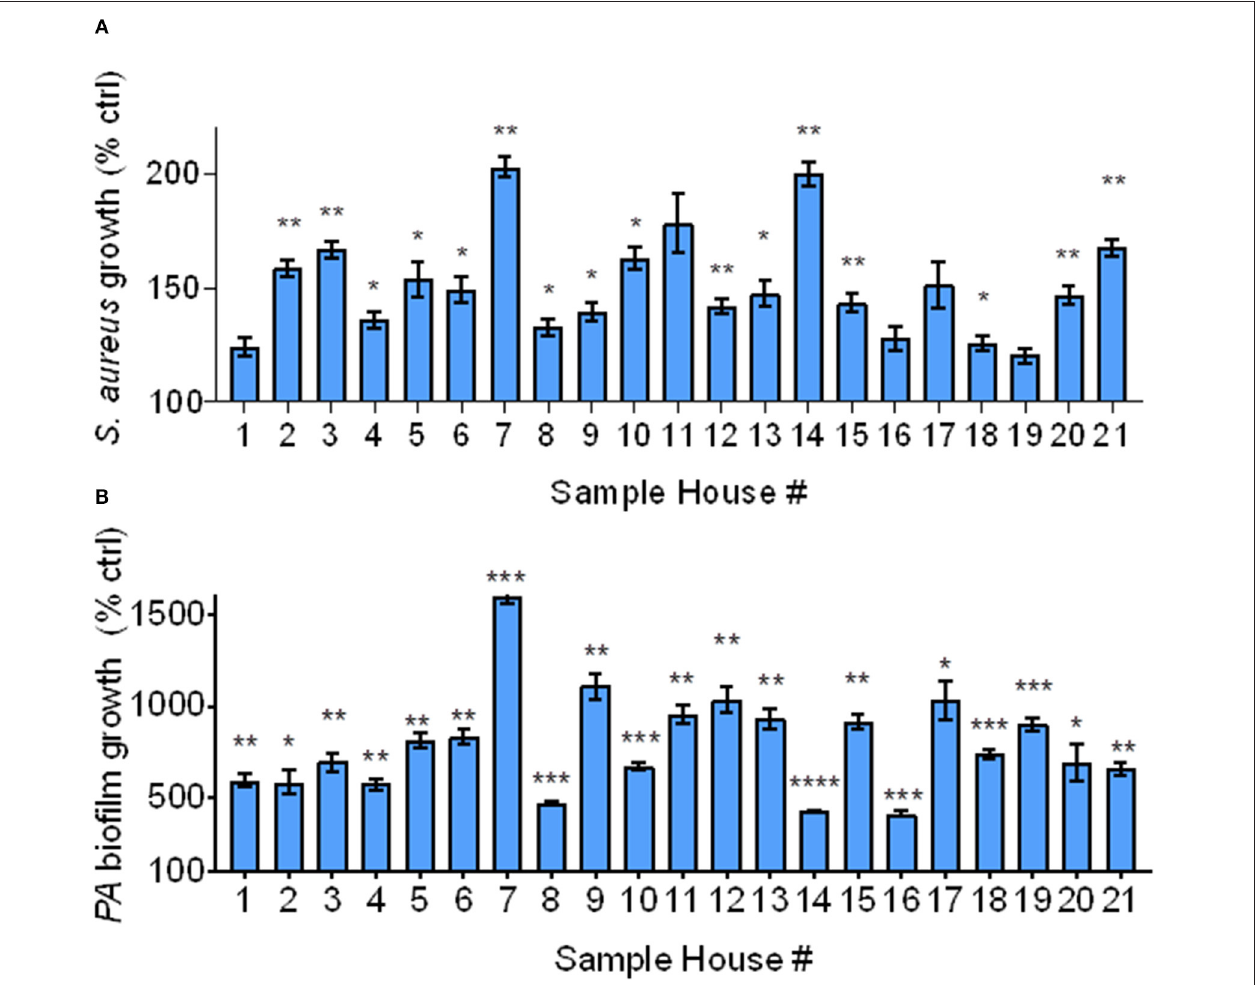
FIGURE 3 | Bacterial growth and biofilm formation using Iowa house IAP. (A) S. aureus bacterial growth relative to the FB control at 4h in the presence of soluble IAP from all homes, error bars represent means and standard error of the means and differences between FB control were compared to each condition using Brown-Forsythe and Welch ANOVA tests *indicates p < 0.05, ** p < 0.01. (B) P. aeruginosa biofilm formation was higher in the presence of all IAP, error bars represent means and standard error of the means and differences between control compared to each condition were assessed using Brown-Forsythe and Welch ANOVA tests * p < 0.05, ** p < 0.01, *** p < 0.001, **** p <